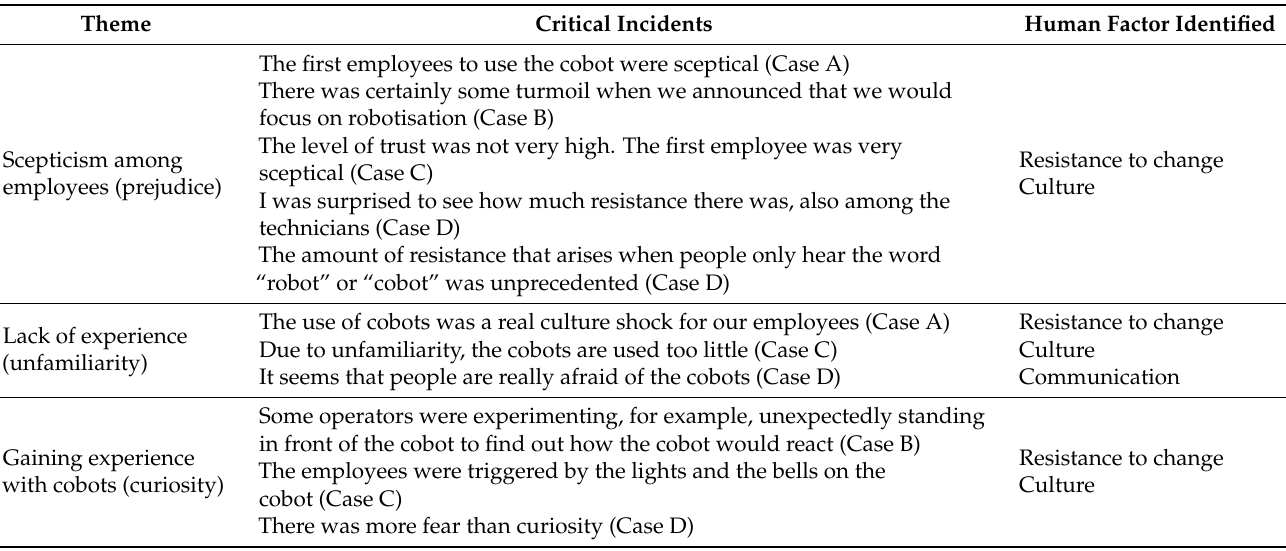
Table 4. Critical incidents and human factors identified related to prejudice, unfamiliarity, and curiosity among employees during the implementation process. Theme Critical Incidents Human Factor Identified